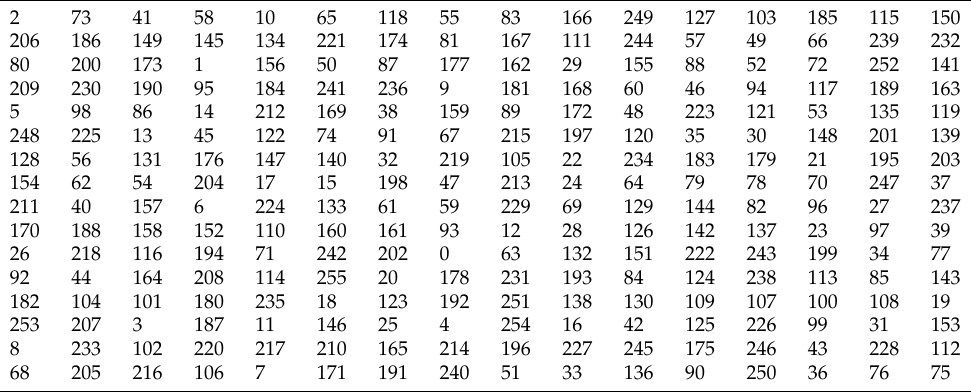
Table 3. The S-box constructed by the proposed